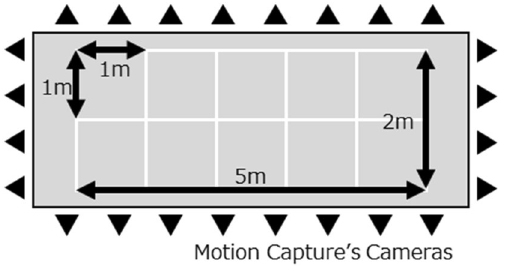
Figure 14. Experimental environment for participant’s walking with optical motion capture system including 24